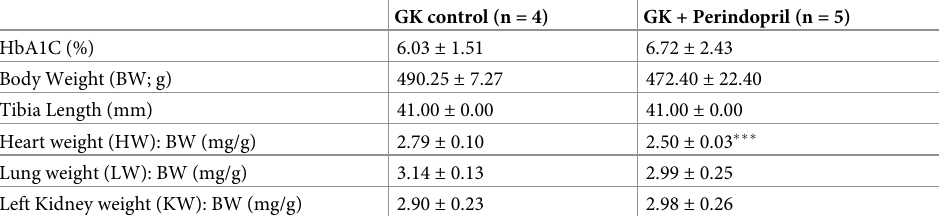
Table 2. Morphometric data of GK and GK rats following treatment with Angiotensin Converting enzyme inhibi- tor